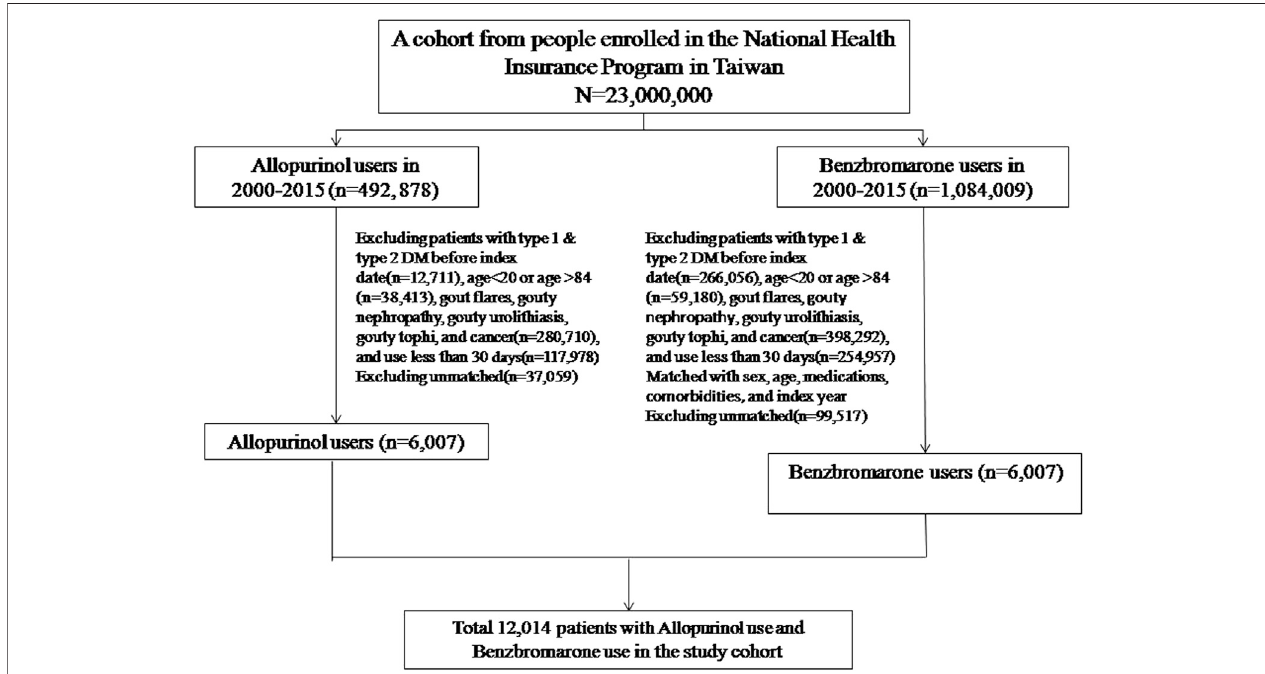
FIGURE 1 | Flowchart showing selection process of study subjects.